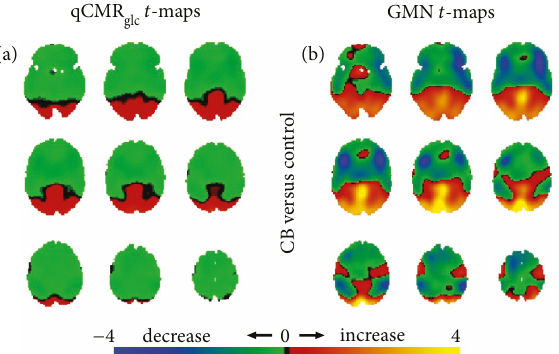
Figure 5: Spatial distributions of metabolic variations with healthy participants with eyes open (i.e., HAEO in Figure 2(a)) versus the eyes closed control group (i.e., HAEC in Figure 2(a)), shown with respect to unthresholded Student ’ s t -maps using (a) qCMR GMN images. (a) For the HAEO group, the unthresholded t -maps with qCMR metabolic increases with eyes open. (b) Conversely, the unthresholded t -maps with GMN revealed regions of increased and decreased metabolism with eyes open. Based on validation of qCMR increases corresponded to about 0.05 μ mol/g/min while with GMN, the global changes were minute. See Figure S5 for thresholded maps (Table 4).